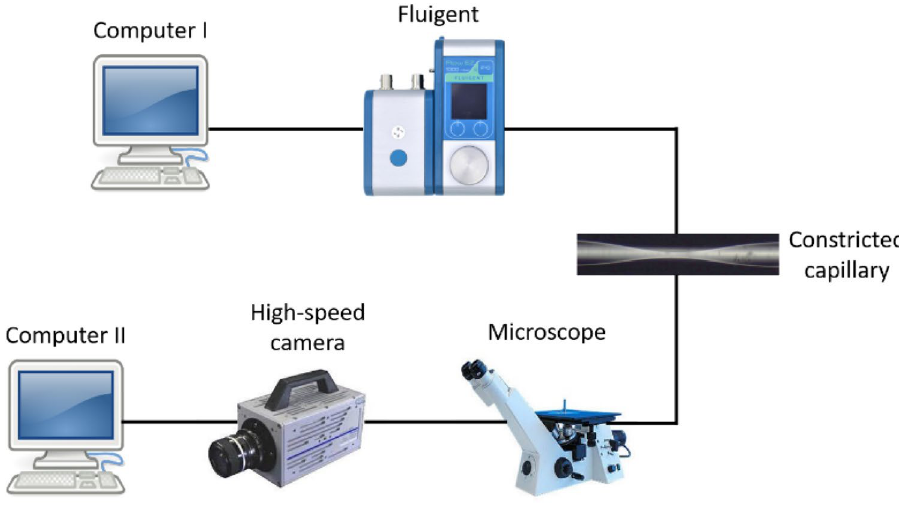
Figure 11. Scheme of the experimental set-up for flowing microcapsules through constricted